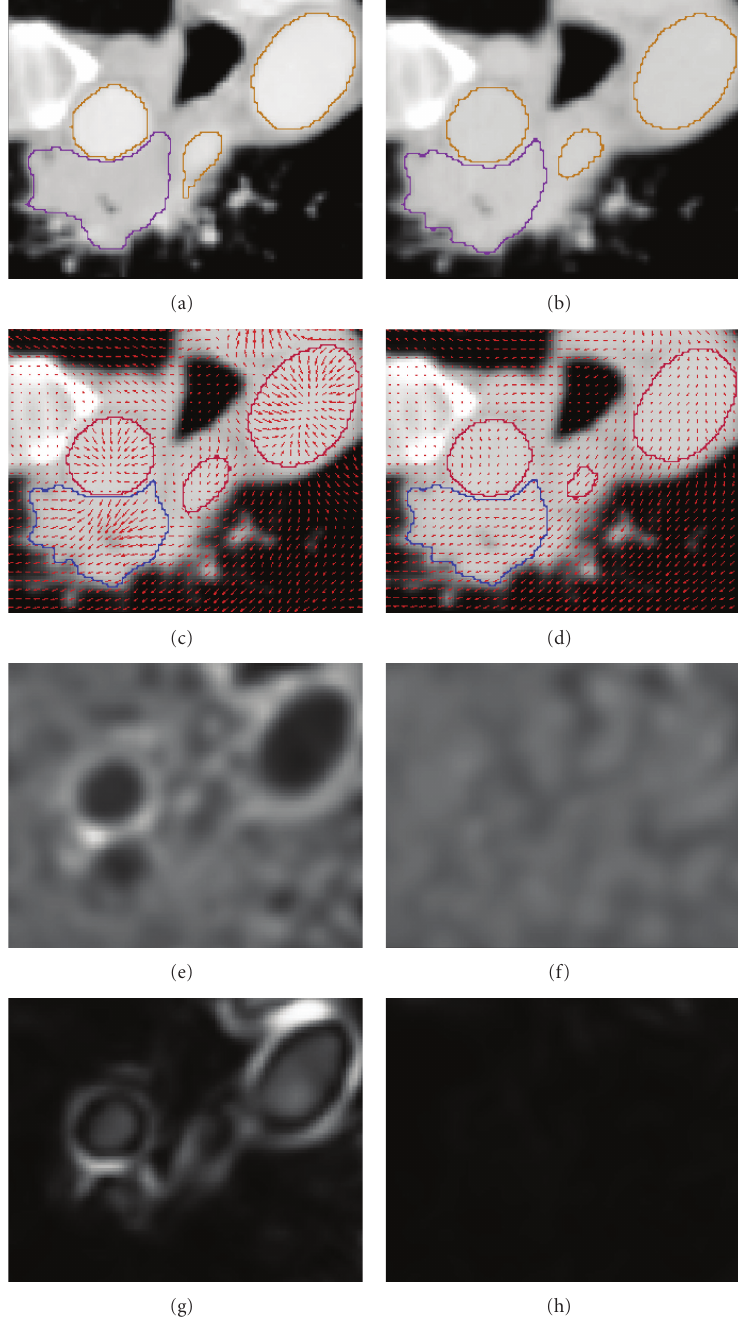
Figure 10: Illustration of the results for the variable contrast experiment. (a) and (b): Fixed image (left) and moving image (right). (c) and (d): Deformed image with deformed contours and displacement field resulting from D-Demons (left) and from D-Morphons (right). (e) and (f): Jacobianof the displacement field resulting from both registrations, represented using the same color scale. (g) and (h): Harmonicenergy of the displacement field resulting from both registrations, represented using the same color